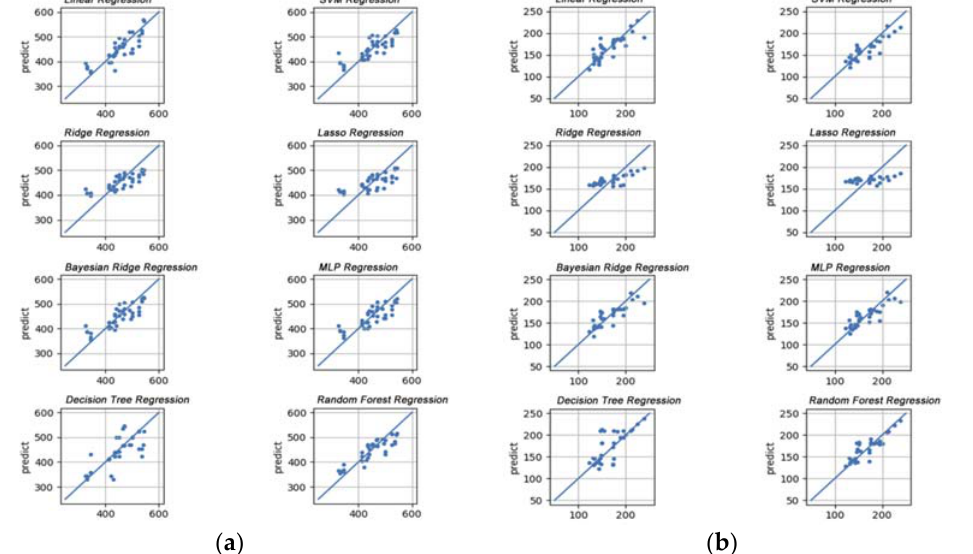
Figure 17. Scatterplot between predicted value and measured value for male and female dataset: ( a ) male; ( b ) female. Table 1. Show the coefficient of determination.